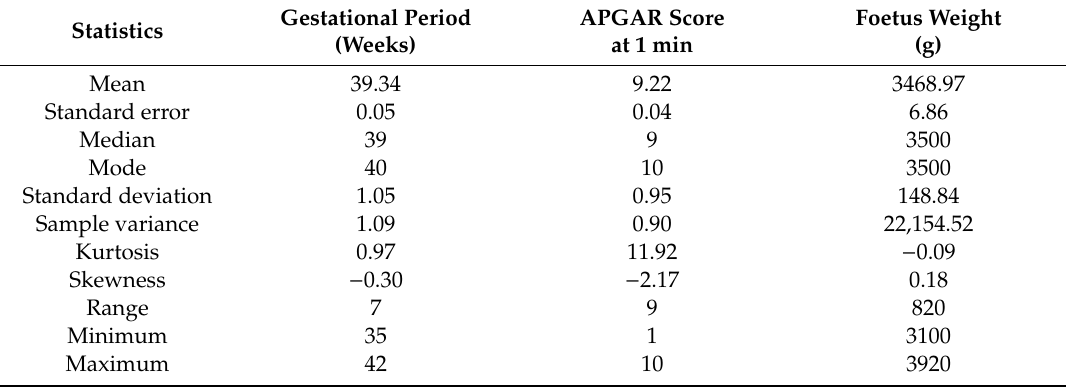
Table 5. Descriptive statistics of obstetrical characteristics for group 1 (healthy pregnant patients, N1 = 471).